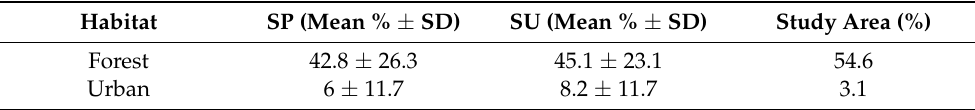
Table 1. Comparison between the percentage distribution of land types by survey unit (SU, 25 km 2 ), by survey point (SP, 1 km 2 ), and across the whole study area. Values were obtained by calculating the mean habitat (forest and urban) percentage and standard deviation for each SU and SP area, as well as for the whole study